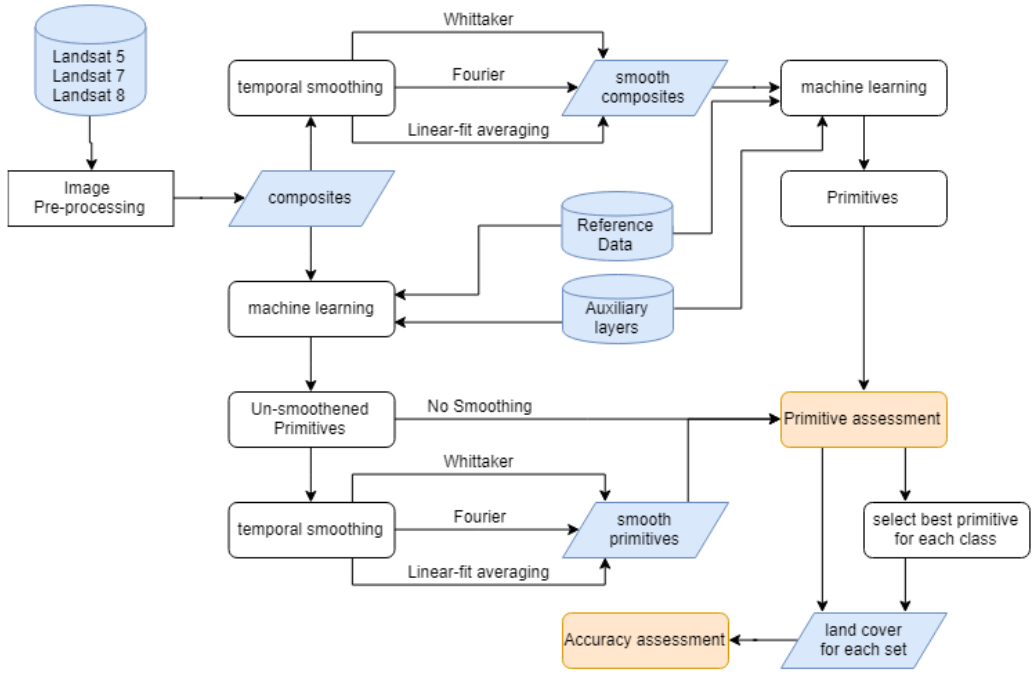
Figure 2. Overall methodology of the